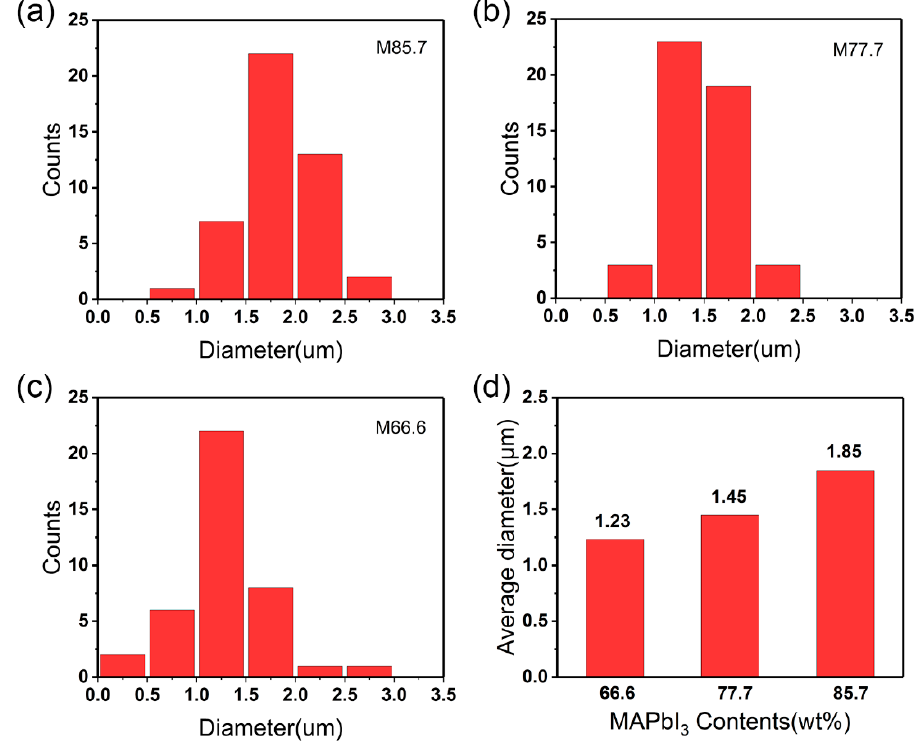
Figure 3. Diameter distributions of the composite fibers. ( a ) M85.7, ( b ) M77.7, and ( c ) M66.6. ( d ) Relationship between the average diameter and MAPbI 3 content.